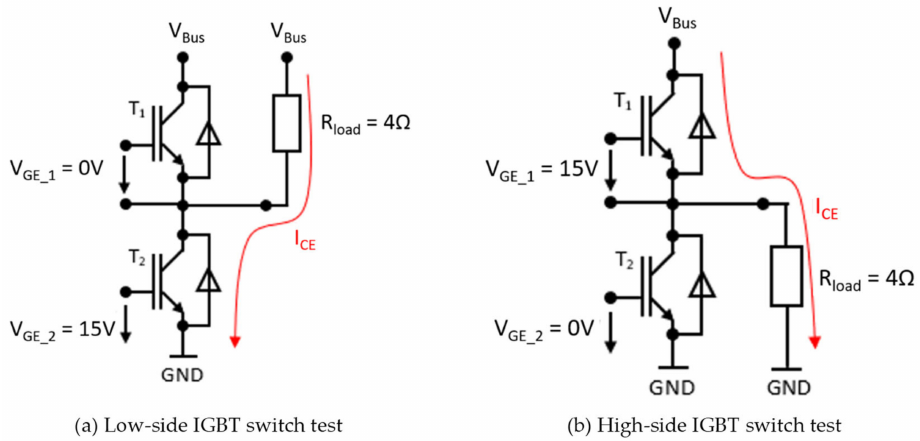
Figure 4. Schematics of the electrical characterization of the half-bridge